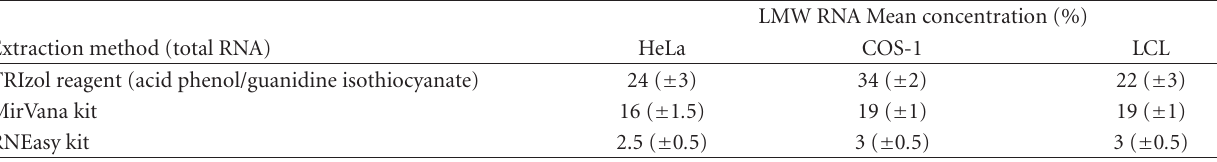
Table 1: Low molecular weight (LMW) RNA mean concentration (% with respect to total RNA) for HeLa, COS-1 and LCL extracted with di ff erent RNA extraction protocols evaluated with Agilent 2100 Bioanalyzer. Standard deviations of at least three independent extractions are reported in parentheses.